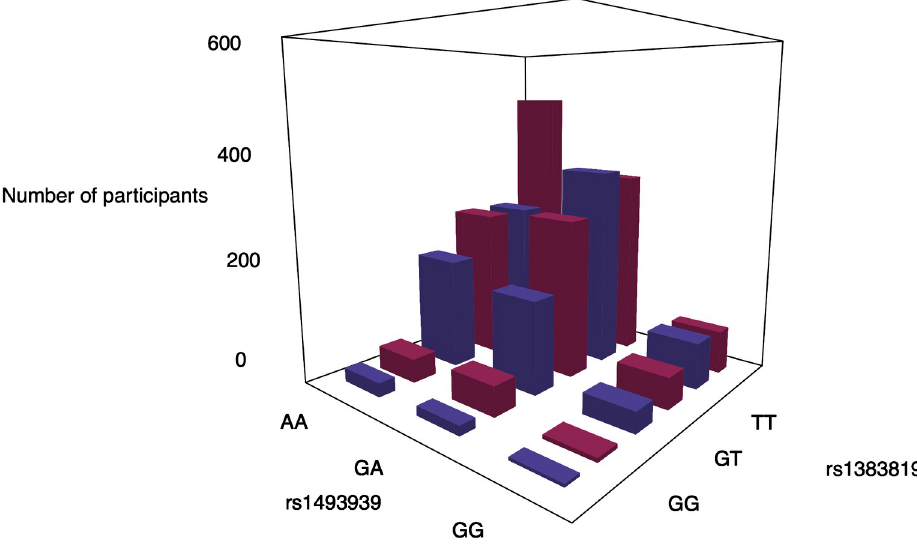
Fig 9. Genotypes combinations between rs1383819 and rs1493939 for the participates with hypertension under main effect filtering. The genotypes of each SNPs were plotted with the number of the participants with hypertension (cases: red) or not (controls: